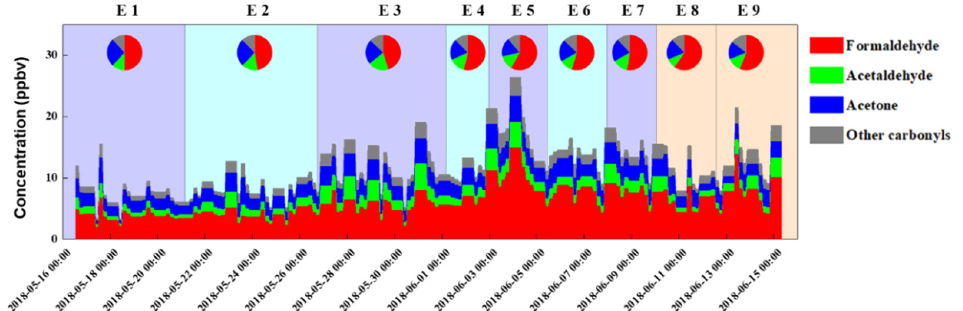
Figure 4. Time series of concentrations and chemical components of carbonyls over the sampling period. E1–E9 correspond to Episode 1–Episode 9 in Figure 3.